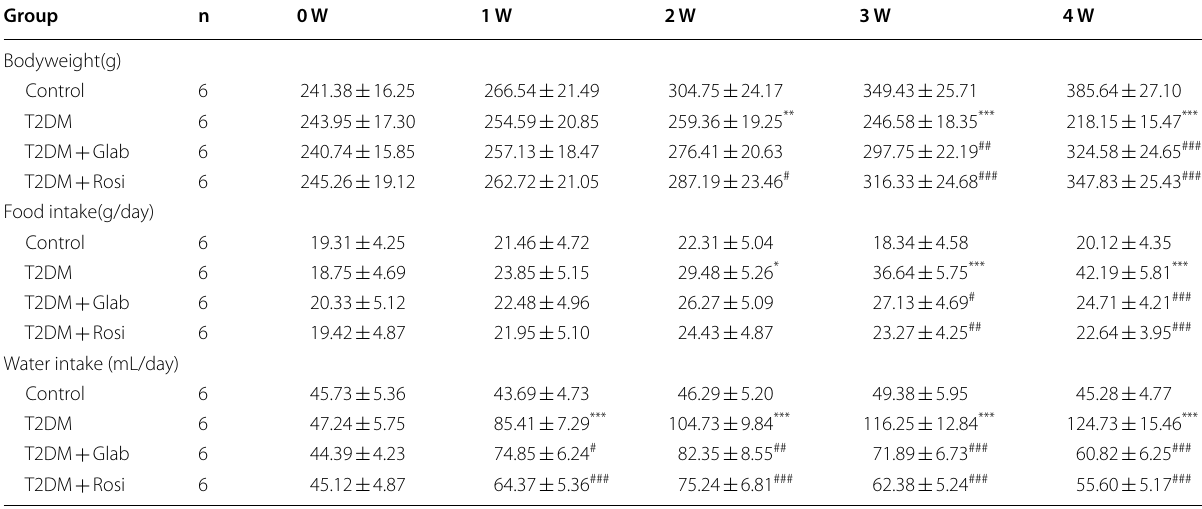
* P < 0.05, ** P < 0.01, and *** P < 0.001, vs. control; # P < 0.05, ## P < 0.01, and ### P < 0.001, vs. T2DM